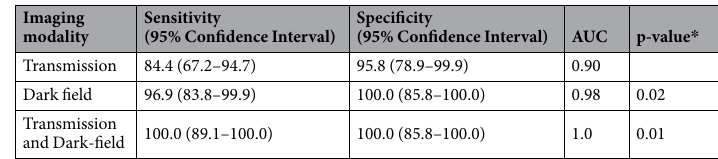
Table 1. Diagnostic accuracy for separate analysis of transmission and dark-field images as well as combined readings. AUC: Area Under the Curve. * Test for significance between transmission and dark-field readings or transmission and combined image analysis.